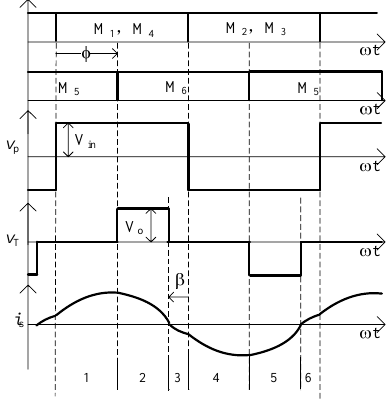
Figure 6. Steady-state waveforms of the CCM3 operation.